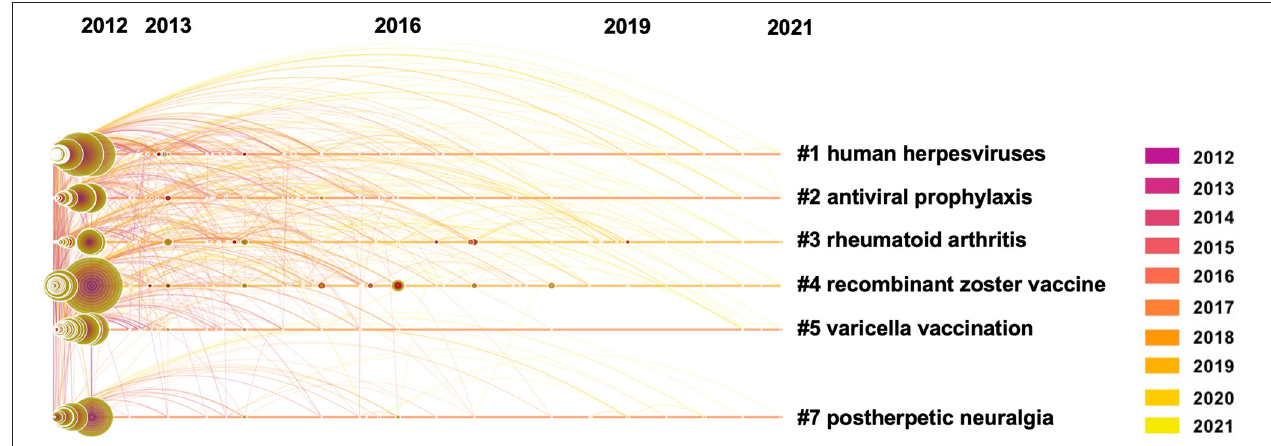
FIGURE 7 | The timeline view of keyword clusters with their cluster-labels on the right.